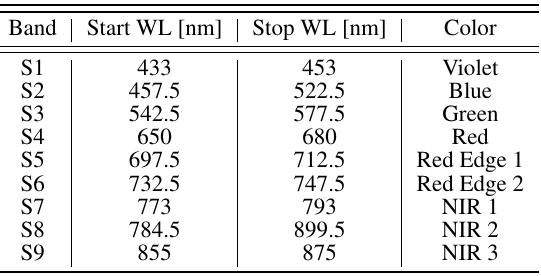
Table 1. Wavelength (WL) intervals of MAIA S-2 bands. Automatic radiometric and geometric correction and co- registration of the bands were computed by means of the MAIA image-processing software before analyzing the images with the proposed interface.